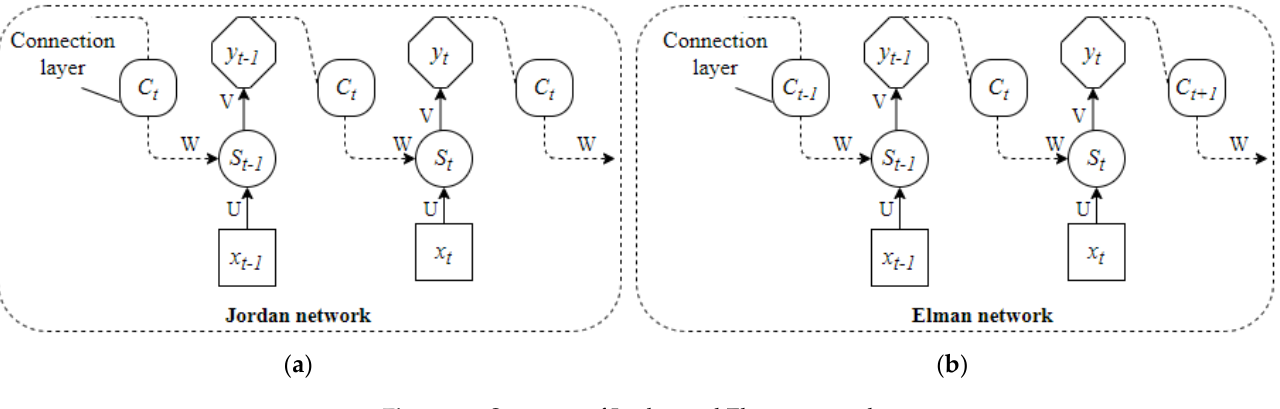
Figure 10. Structure of Jordan and Elman network.